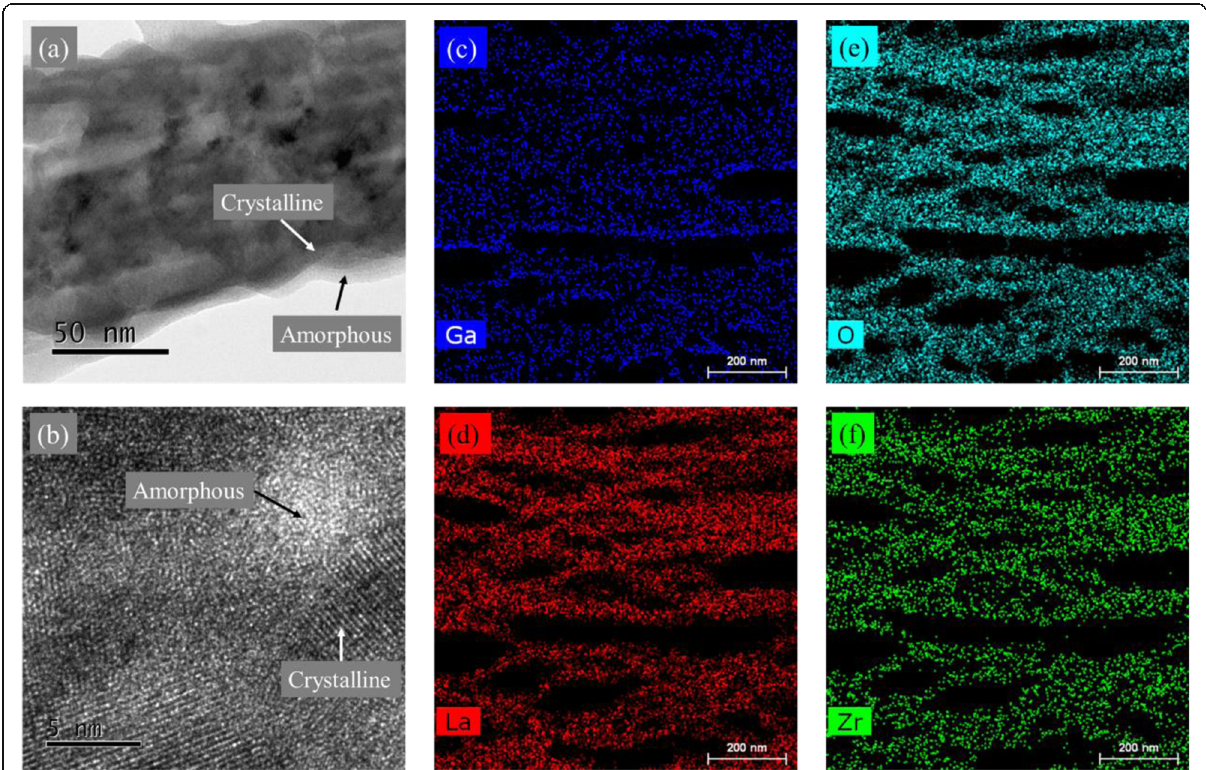
Fig. 5 HRTEM images ( a , b ) and elemental mapping ( c for Ga, d for La, e for O, f for Zr) of LLZO thin film